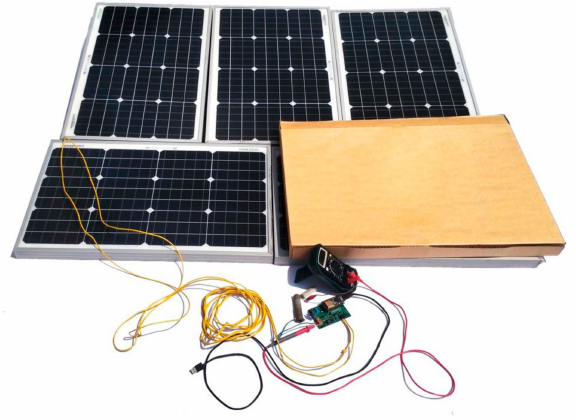
Figure 14. Four PV modules are active, one is shaded.